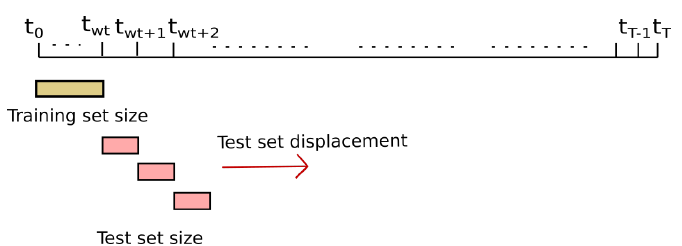
Figure 8. Case 3: Training set size fixed. Test set size fixed but moves in forward direction.